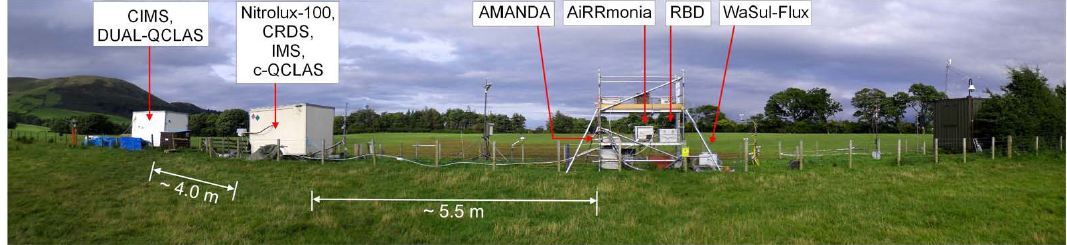
Fig. 1. Intensively managed grassland site (Easter Bush) with instruments, looking from the S field towards the N